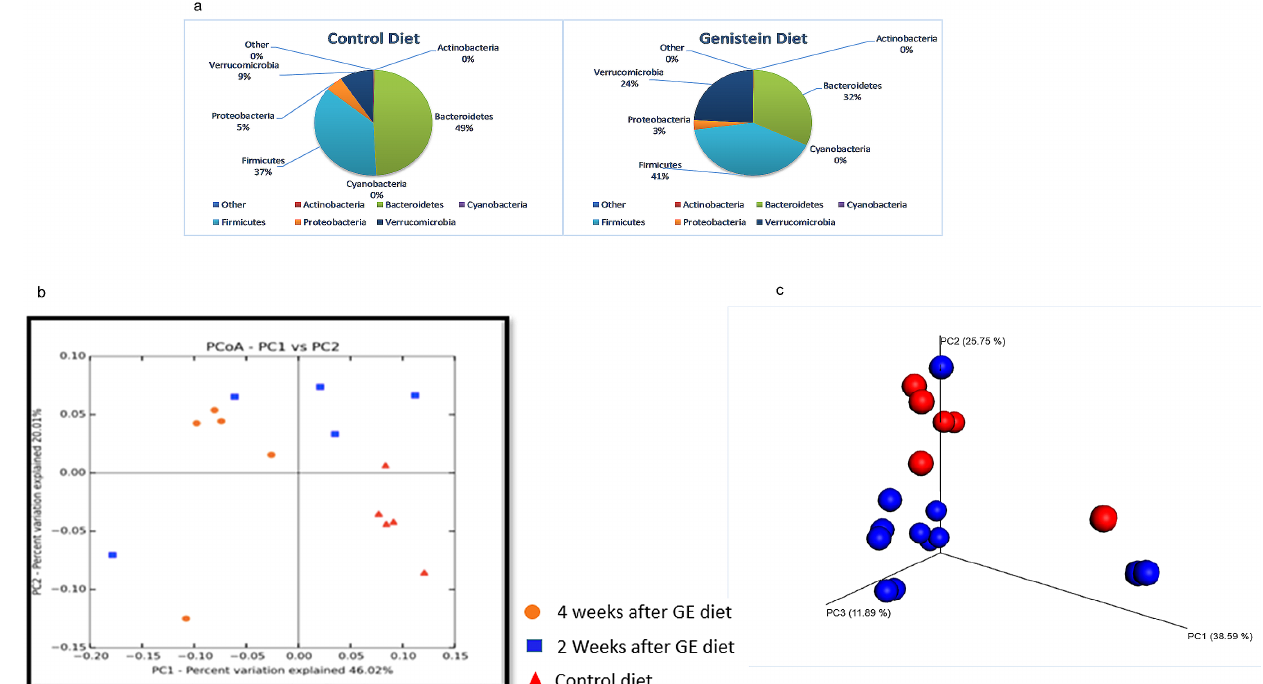
Fig 4. Microbiota change four weeks after introduction of GE diet. (a) Phylum level changesin microbialabundance four weeks after introduction of GE diet. There was a significantincreasein Verrucomicrobia (p = 0.02) in mice on the GE diet. (b)Weightedunifrac 2. (c) 3D PCoA plots (Bray Curtis) showinga distinct clustering of the control-fed(red) and GE-fed diet groups(blue).